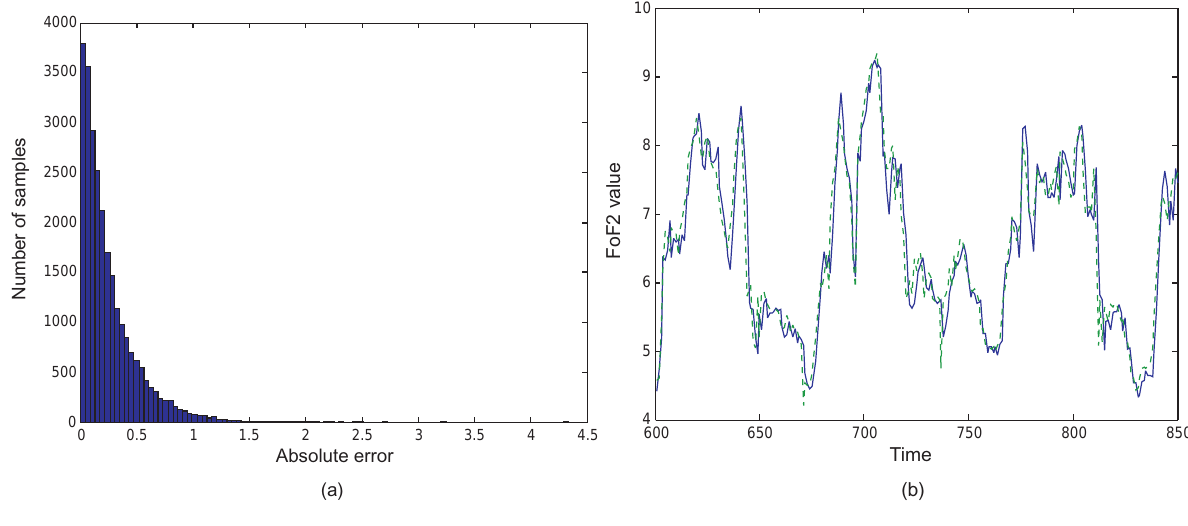
Fig. 5. One-step ahead (15min) prediction, with the 9 nearest neighbor predictor. (a) The histogram of the absolute differences of the computed and the actual outputs, for the test set. (b) The actual (solid line) and the computed (dotted line) outputs for a short time interval of the test